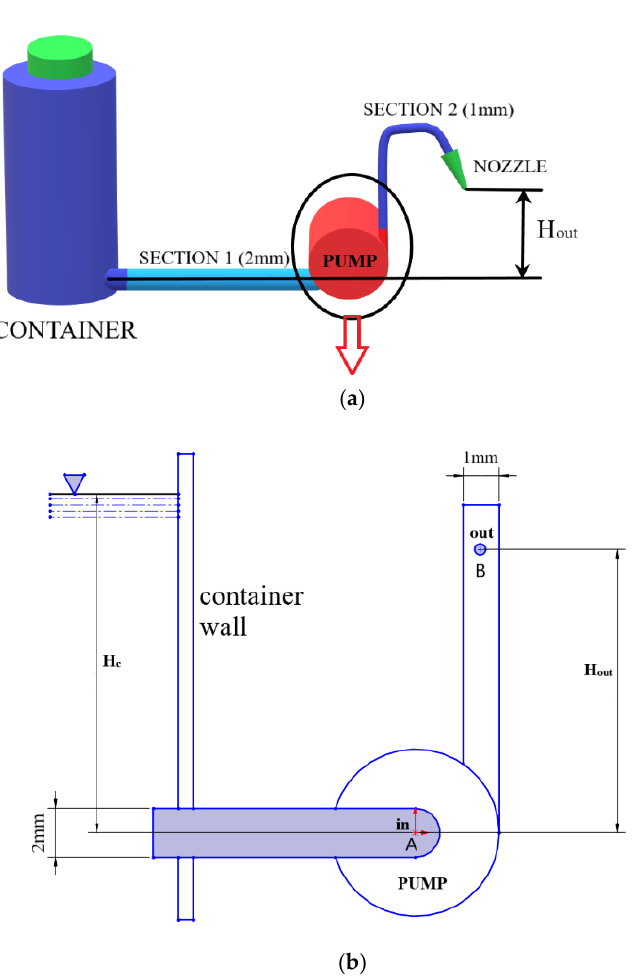
Figure 2. ( a ) Three-dimensional graphical representation of the piping system, ( b ) schematic diagram of the pump system